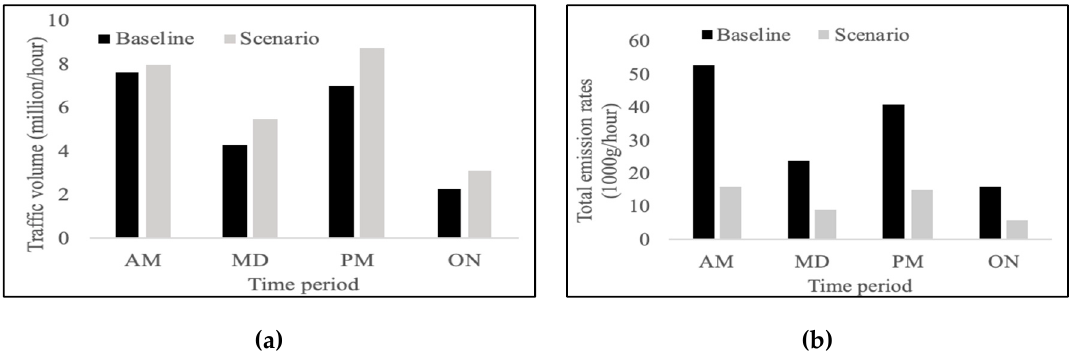
Figure 3. Results of vehicle emissions. ( a ) Total hourly traffic volume, ( b ) Total emission rates.